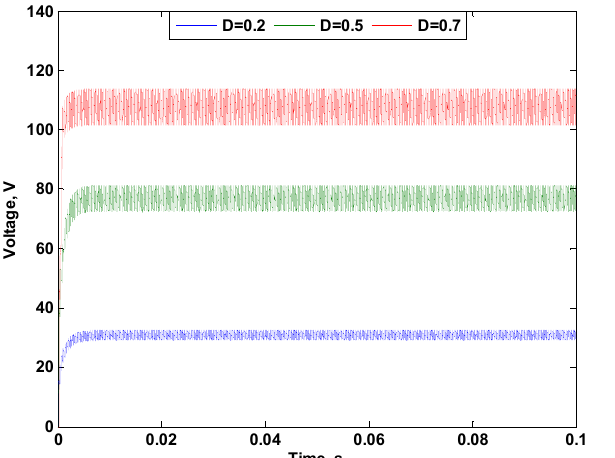
Figure 8. Voltage at the terminals of the first-stage capacitor at the same adopted duty ratios in Figure 7.